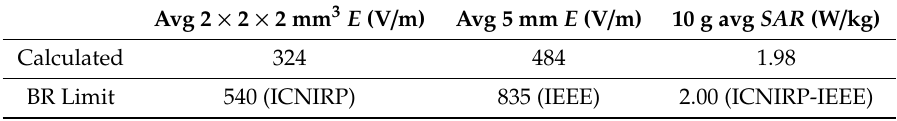
Figure 7. Duke human body model (HBM) with transmitting coil ( a ), magnetic flux density distribution in dB inside the torso normalized to 100 µ T ( b ), maps of induced E -field ( c ) and SAR ( d ) inside Duke’s torso normalized to the peak values. Table 1. Maximum avg. internal E and specific absorption rate (SAR) values for MMF = 23.7 At.